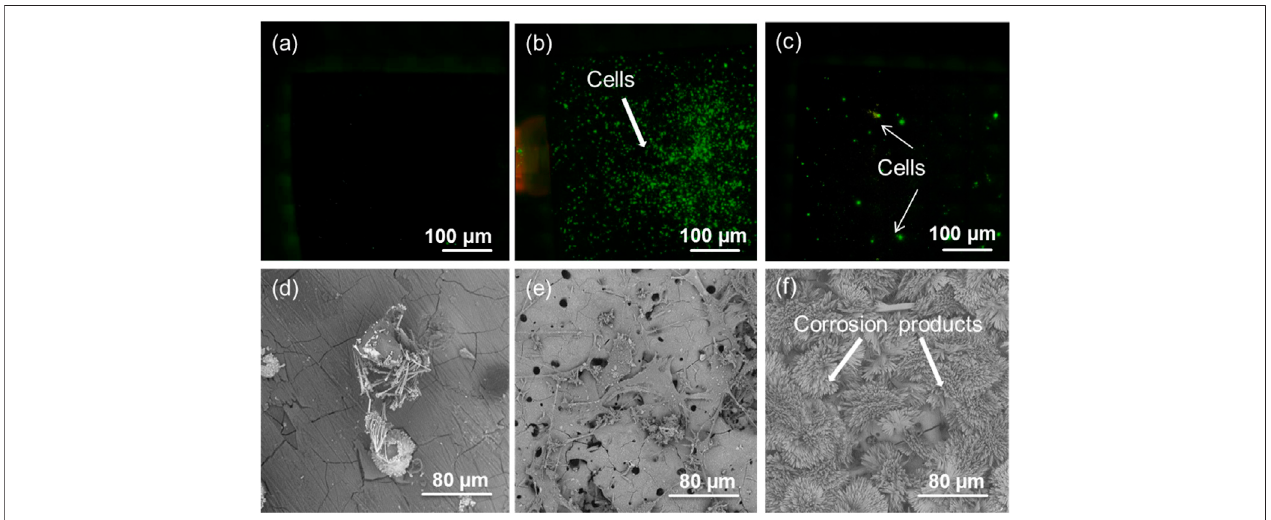
FIGURE5| Live/deadstainingandSEMobservationonthesurfaceofuncoatedandcoatedMgalloyaftercellculturefor7 days. (A) and (D) uncoatedMg, (B) and (E) PPEO, (C) and (F) PPEO (2 g_particle).